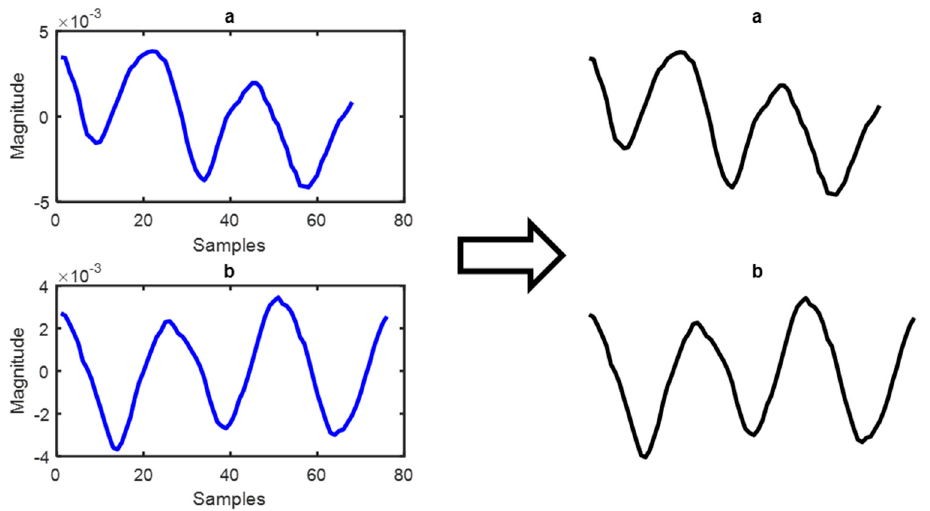
Figure 6. Heart rate patterns extracted for four consecutive peaks: ( a ) direct plot of the pattern; ( b ) image transformation into grayscale image for CNN features extraction.